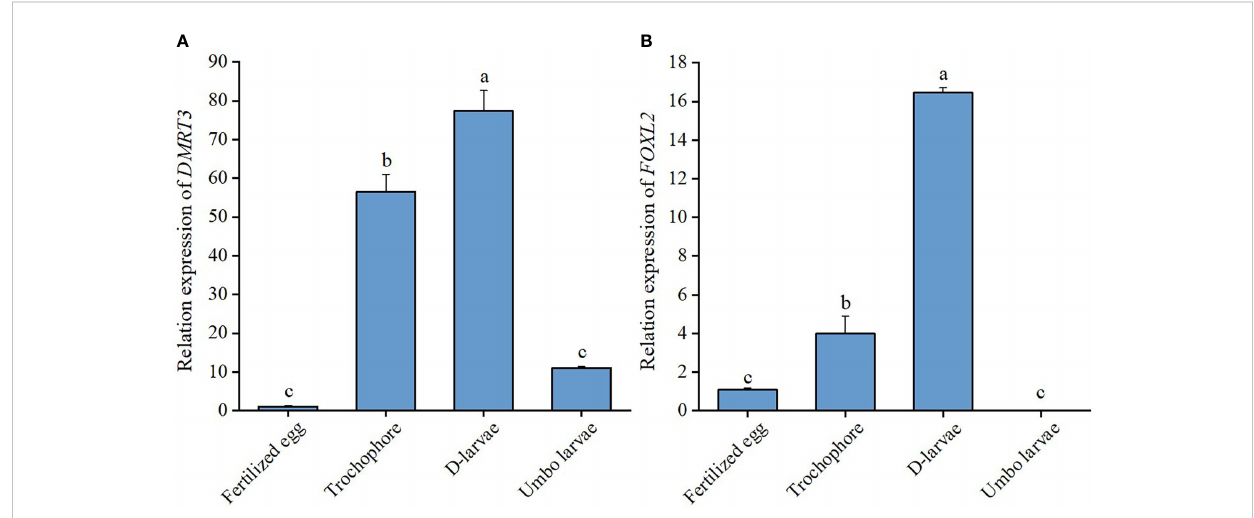
FIGURE 7 The relative expression levels of DMRT3 (A) and FOXL2 (B) in larval development stages of C. sinensis . Different letters represent signi fi cant differences ( P<0.05